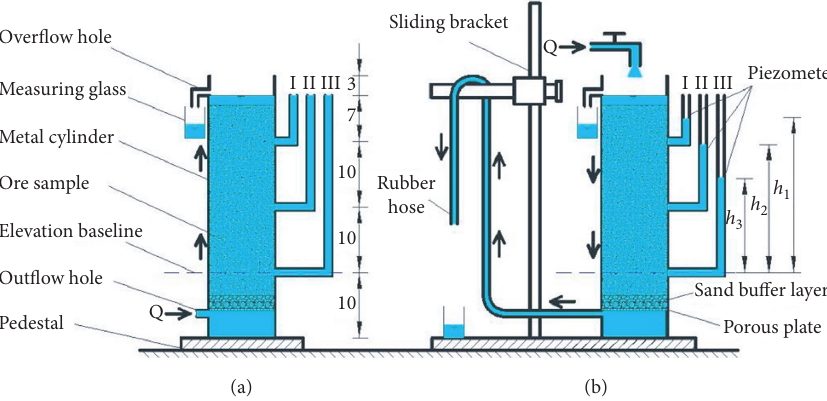
Figure 4: Schematic of permeameter (cm). (a) Layered saturation stage. (b) Permeation test Table 2: Ratio and characteristic parameters of samples. Sample no.